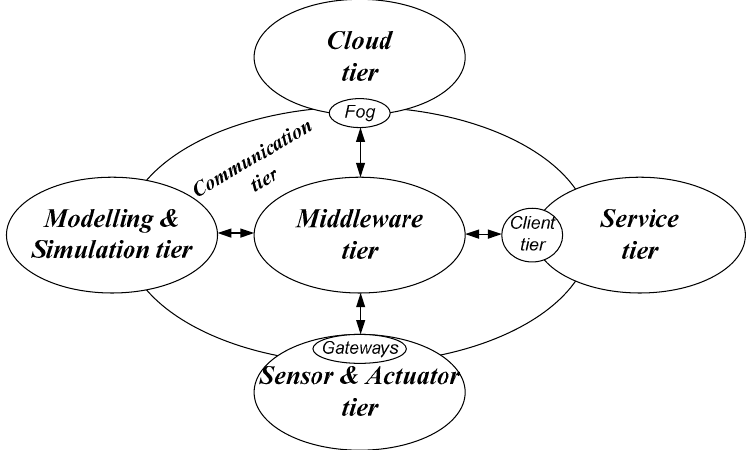
Figure 4. The seven-tier architectural structure of EMULSION.